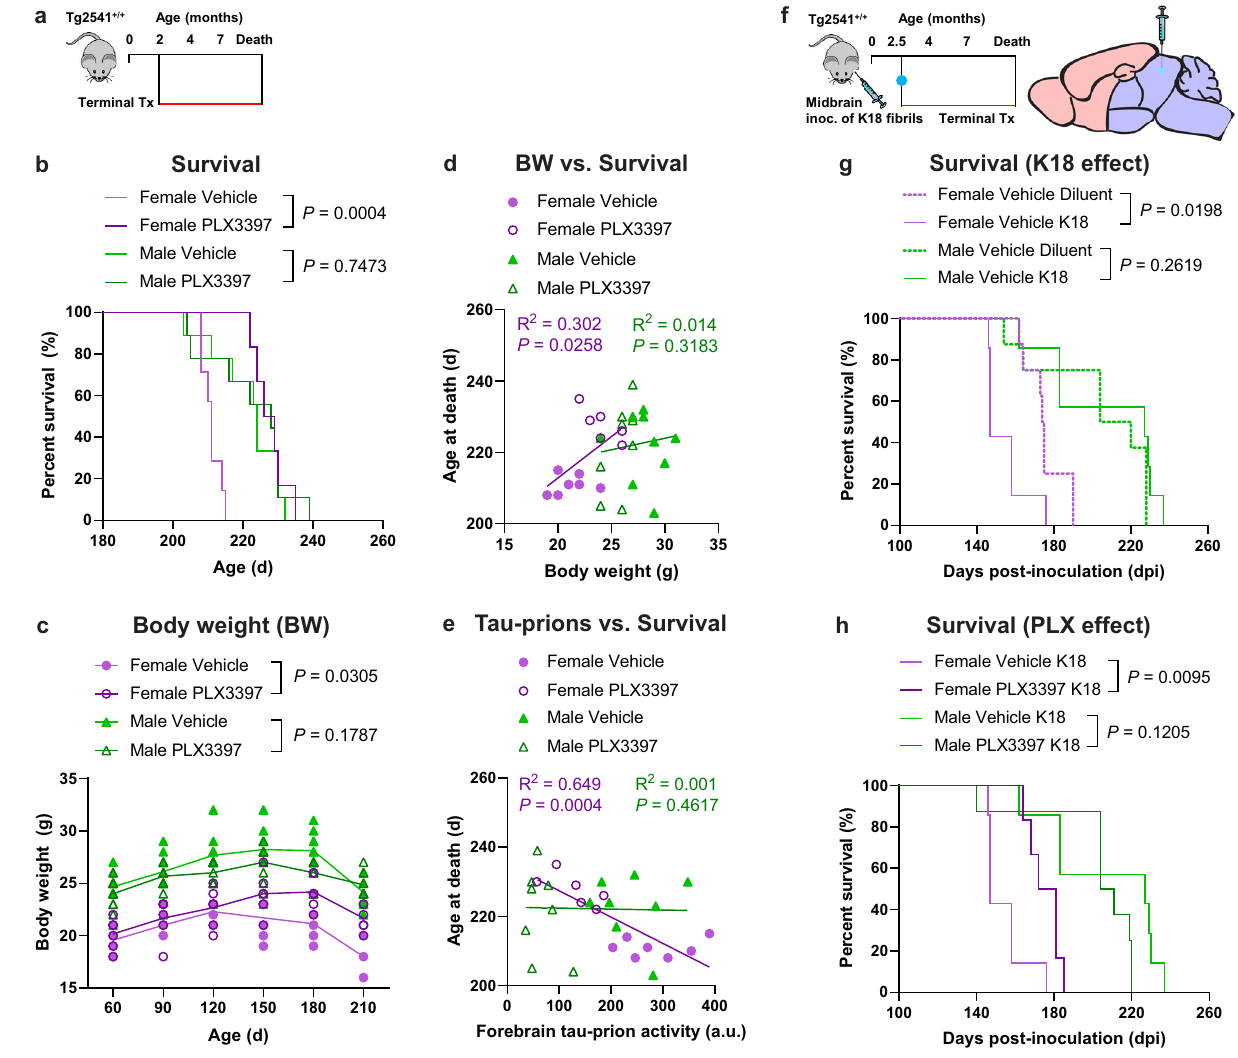
Fig. 2|CSF1RinhibitionextendssurvivaloffemaleTg2541mice.a Schematicof terminalPLX3397treatment(275mg/kgoral)ofTg2541micefrom2moofageuntil death. b Kaplan – MeierplotshowingpercentsurvivaloffemaleormaleTg2541mice treated with vehicle or PLX3397. n =7 mice for Female Vehicle; n =6 mice for Female PLX3397; n =9 mice for Male Vehicle; n =9 mice for Male PLX3397. c Body weightsoffemaleormaleTg2541micetreatedwithvehicleorPLX3397.Differences in weight between vehicle and PLX3397 treatment in female or male mice were evaluated bymixed-effectsanalysis(Restrictedmaximumlikelihood).Eachsymbol represents an individual mouse and lines indicate group means. d , e Correlation plotsforbodyweight at180d ofage ( d ) or forebraintau-prionactivity atdeath( e ) and survival for female or male Tg2541 mice treated with vehicle or PLX3397. Each symbol represents an individual mouse and linear regression lines are shown for female or male mice, with vehicle- and PLX3397-treated mice combined. Pearson ’ s correlation analysis was performed and the results are shown. f Schematic of